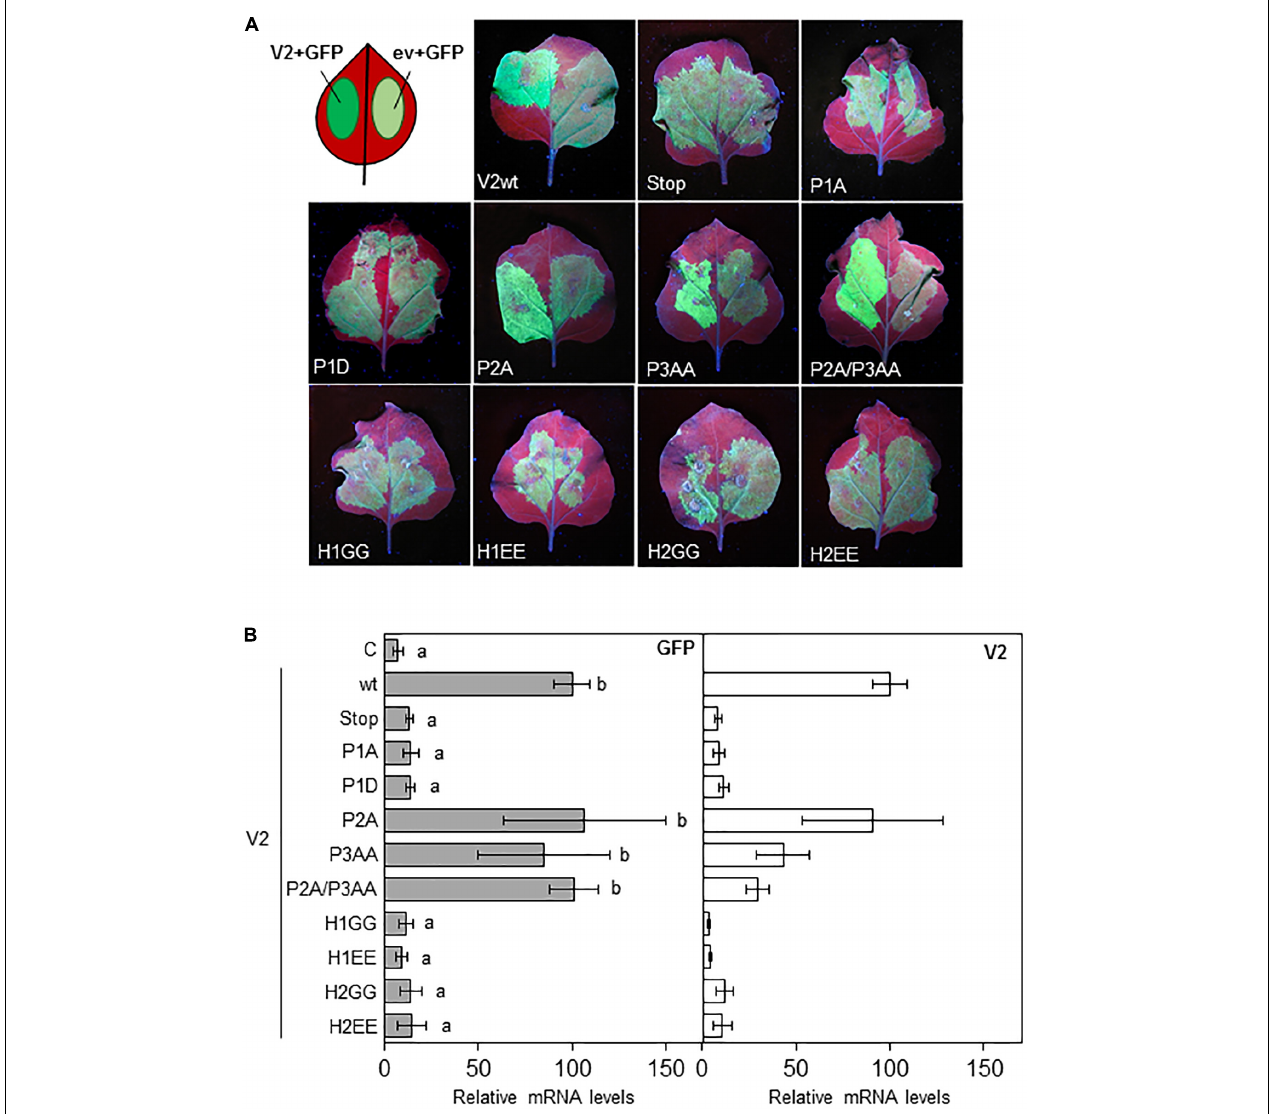
FIGURE 2 | Local PTGS suppression activity of V2 mutants in wild-type N. benthamiana plants. (A) Leaves from N. benthamiana plants infiltrated with a mixture of two A. tumefaciens cultures expressing GFP and the indicated version of V2, were photographed under UV light at 5 dpi. Wild-type V2 protein (wt) and the empty vector (C) were used as a positive and negative control, respectively. (B) Relative GFP and V2 mRNA levels (RT-qPCR) in infiltrated tissues at 5 dpi. GFP or V2 transcript levels were normalized to EF1 and are presented as the relative amount of transcripts compared with the amount found in wild-type V2 (wt) samples (set to 100%). Bars represent mean values ± standard error (SE) for 4–8 pools of two leaves from 3 to 4 plants each one. Mean values marked with different letter (a or b) indicate results significantly different from each other, as established by One Way ANOVA (Dunnett’s Multiple Comparison Test; P <